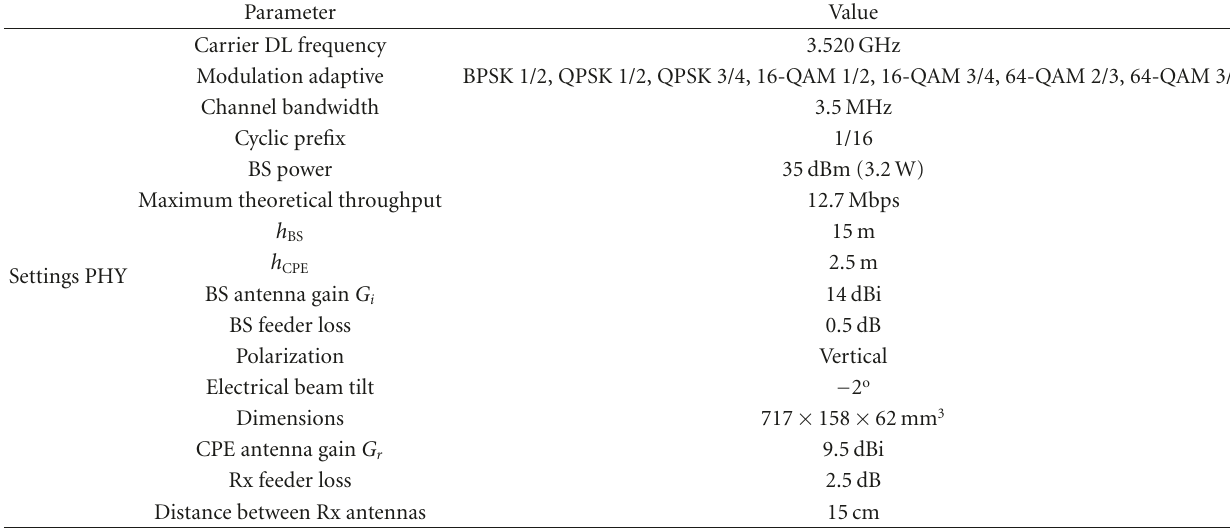
Table 1: Characteristics of the considered WiMAX system.